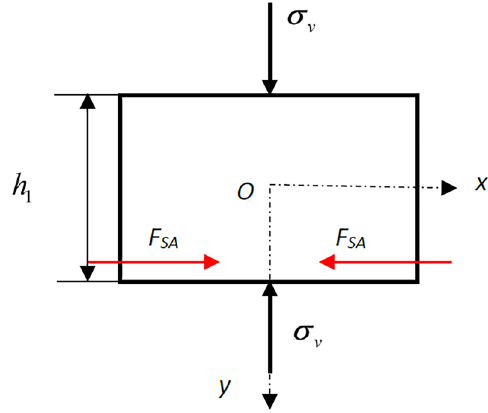
Figure 9. Mechanical model of the main rock mass.